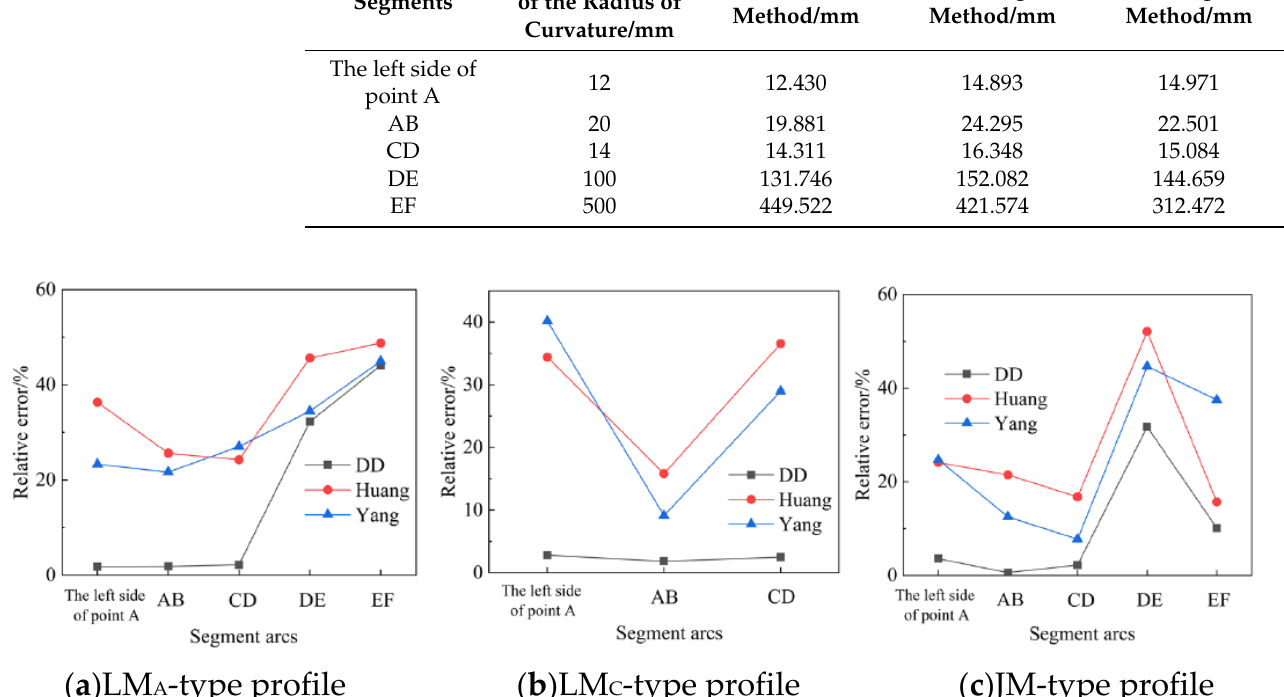
Figure 13. The relative errors of measuring different types of wheel profiles’ radii of curvature. ( a ) LM A -type profile. ( b ) LM C -type profile. ( c ) JM-type profile.